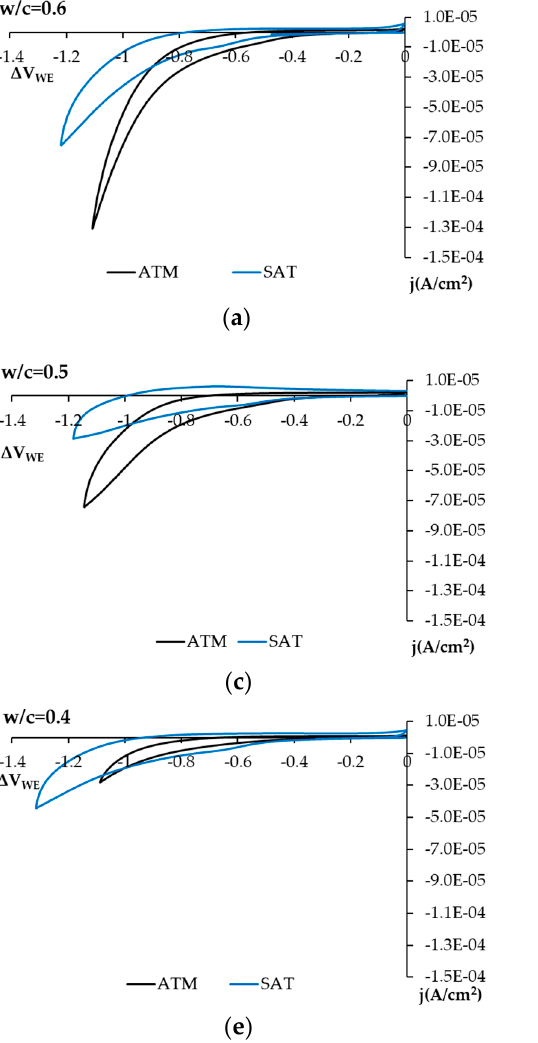
( b ) n1 Figure 11. Average value of the slope (m1) and intercept (n1) of lines 1 and 2 for each studied dosage and each state. ( a ) Data of the slope of line 1 (m1). ( b ) Data of the intercept of line 1 (n1). The data obtained for the non-saturated H 2 O samples (VACUUM, 500 mbar, and ATM) reveal that the parameter m1 value rises as O 2 availability increases for all concretes. The highest absolute parameter m1 value is obtained in all concretes for higher O 2 availa-